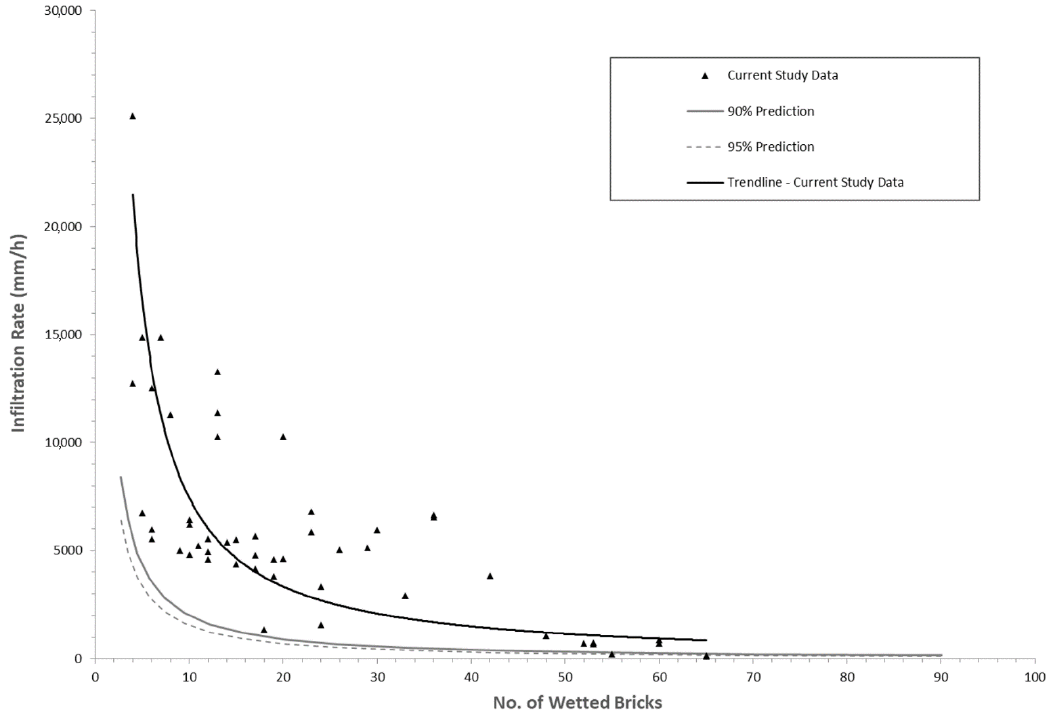
Figure 9. The data obtained in the present study fitted with a power distribution together with 90% and 95% prediction limits.